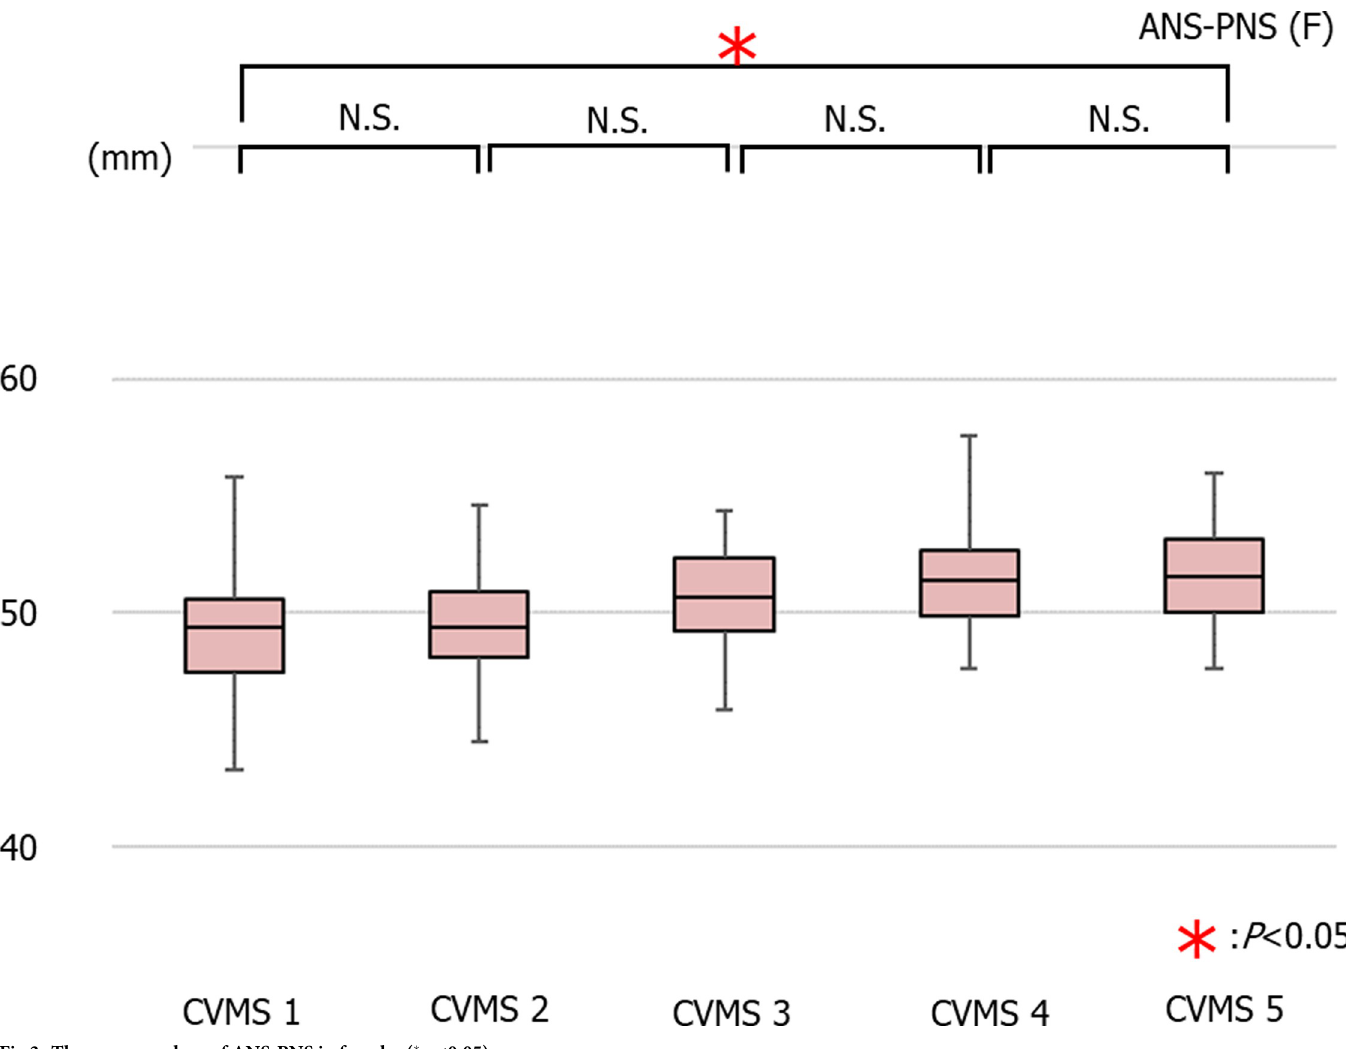
Fig 3. The average values of ANS-PNS in females ( � p <